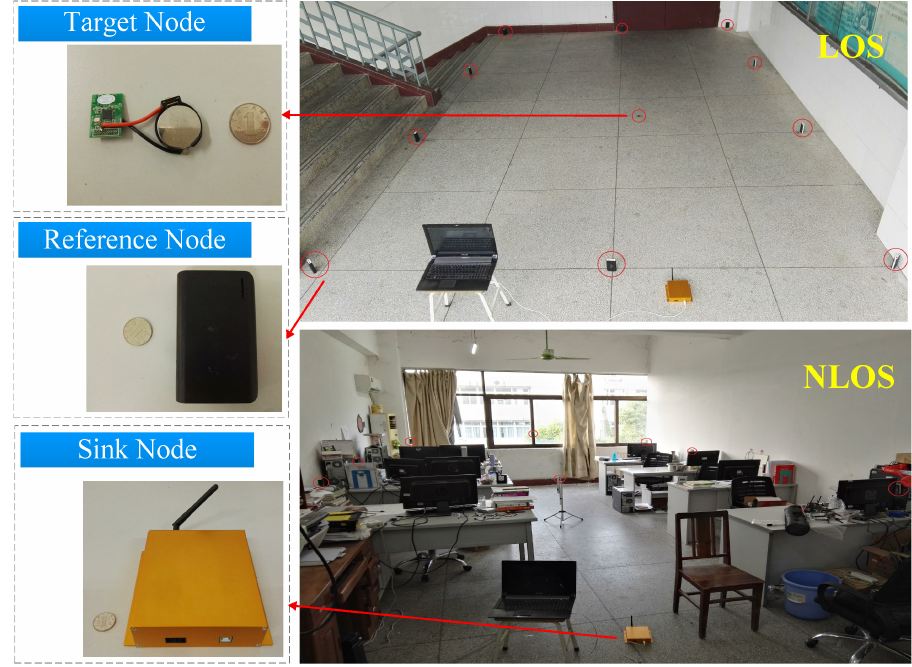
Figure 5. The experimental